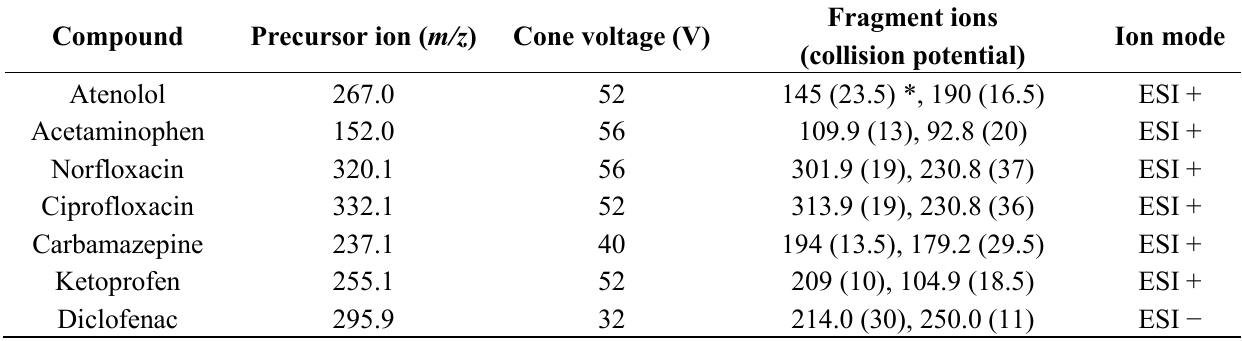
Table 2. Mass spectrometer parameter for the determination of target analytes.